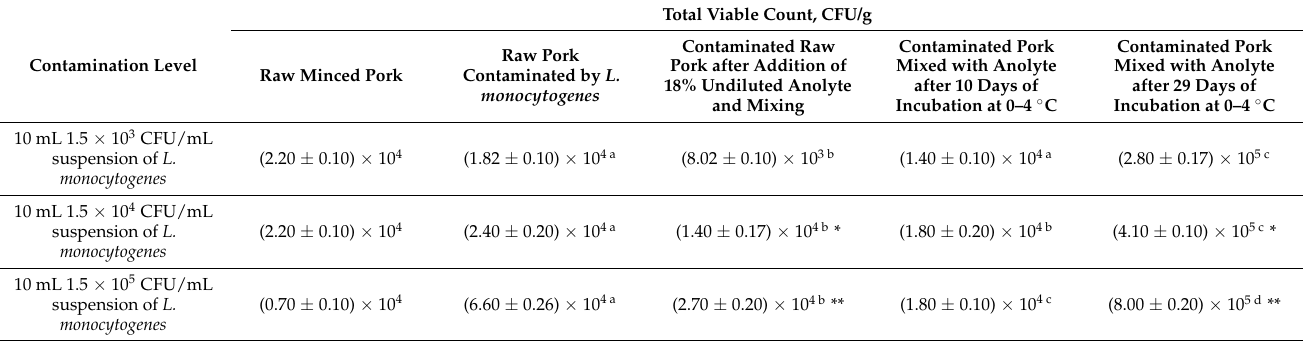
Table 5. Effect of anolyte on the total viable count of minced pork contaminated by L. monocytogenes .